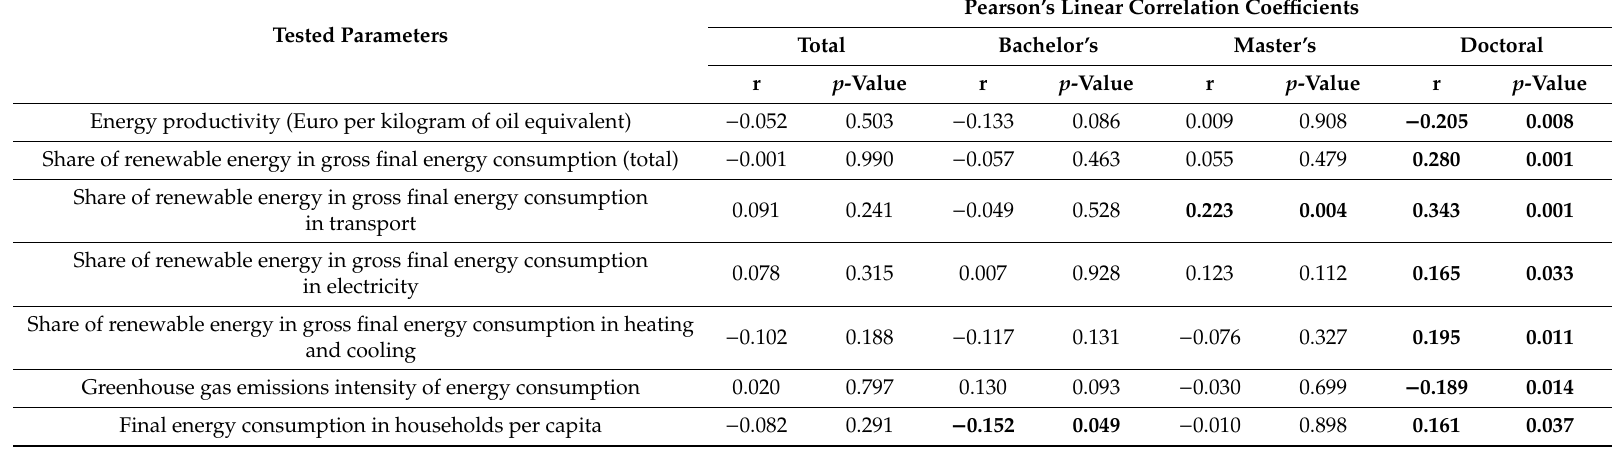
Table 4. Pearson’s linear correlation coe ffi cients between the number of electricity and energy students and the parameters assessing the achievement of circular economy in the energy